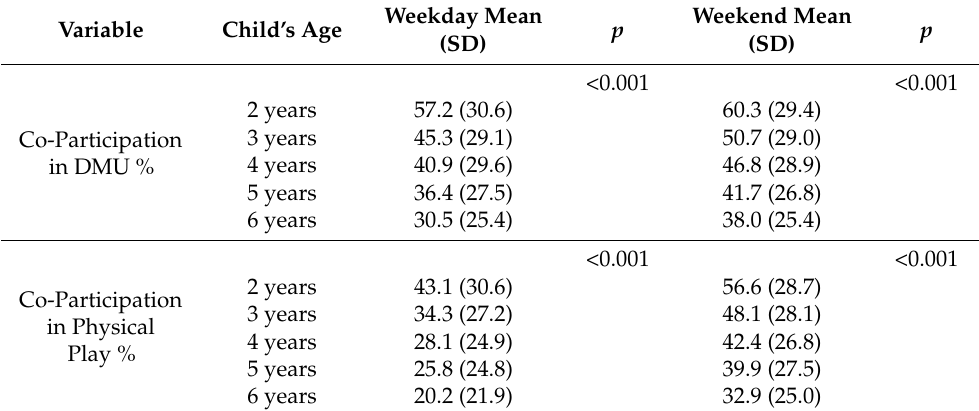
Table 3. Parental co-participation in child’s digital media use (DMU) and physical play by child’s